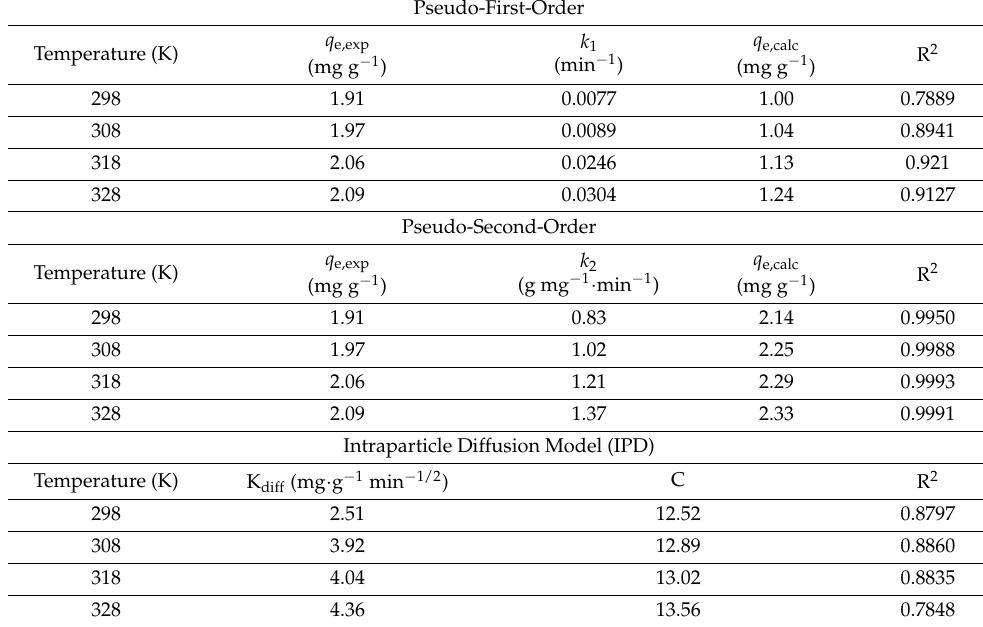
Table 3. Kinetic parameters for the adsorption of Sc(III) onto